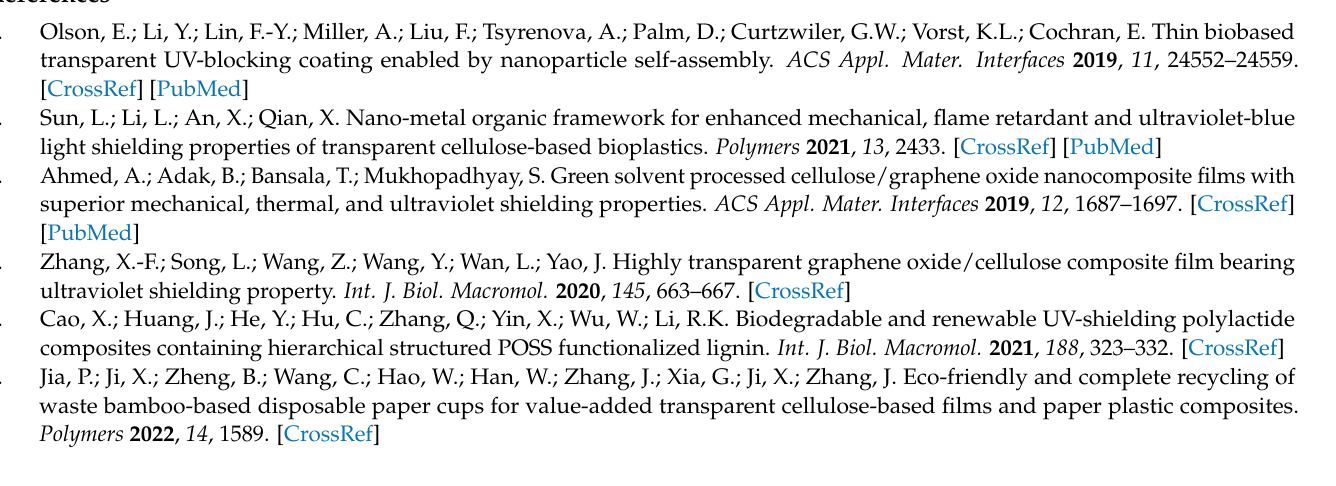
Figure S4: AFM images of pure CCF and M(Fe)CCF3; Figure S5: (a) FTIR spectra of M(Fe)CCF1 and M(Fe)CCF2, (b) XRD patterns of M(Fe)CCF1 and M(Fe)CCF2; (c) The full wide-scan XPS spectra of M(Fe)CCF1 and M(Fe)CCF2. Figure S6: Thermogravimetric curves of CCF and M(Fe)CCFs. Figure S7: Deposition ratio of MIL-88A(Fe) into